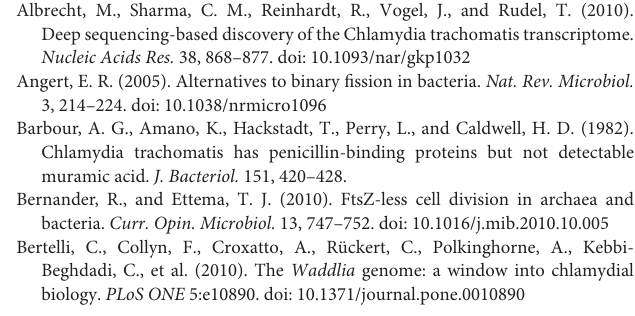
TABLE S1 | Division and cell wall cluster and PG synthesis protein detection in PVC. Due to the divergence of the PVC species from model organisms and for the sake of completeness, two complementary searches were combined (Sheet 1). We first performed two iterations of Psi-Blast using the W. chondrophila (Sheet 2) and E. coli (Sheet 3) proteins as a query on the non-redundant GenBank (nr) database, using default parameters and accepting hits with an e -value below 10 − 3 . One additional iteration was run on the PVC proteomes with the obtained profile as query. A reciprocal search was then used to verify that the starting proteins were found when using the hit as a query. The PVC hit was only accepted if the reciprocal search found the starting sequence. Each cell contains two identifiers, if the reciprocal best hits are different, the first one corresponding to the hit from the W. chondrophila search (left), followed by the hit from the E. coli search (right). In most cases, the two approaches hit the same proteins, reinforcing their results. Only one identifier is indicated if the reciprocal best hits are the sames. Sheets 2 and 3 show the e -values of detection corresponding to the searches from the W. chondrophila and E. coli proteins, respectively. NA, not applicable; PF, binary fission planctomycetes; PB, budding